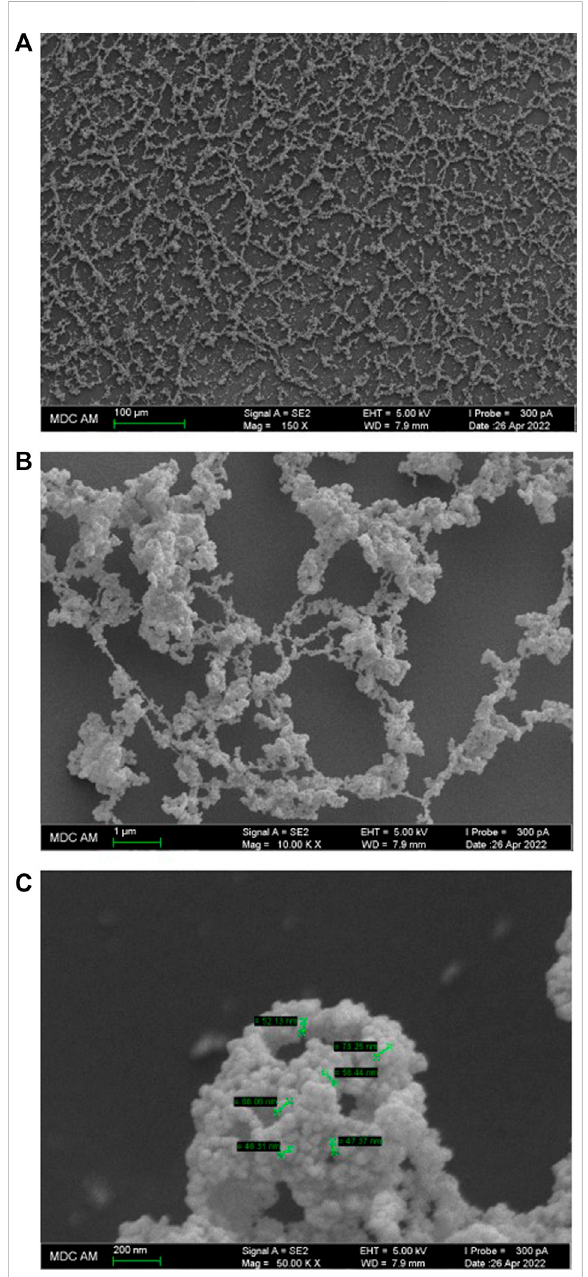
FIGURE 4 SEM images of the surface of the Dox aqueous system